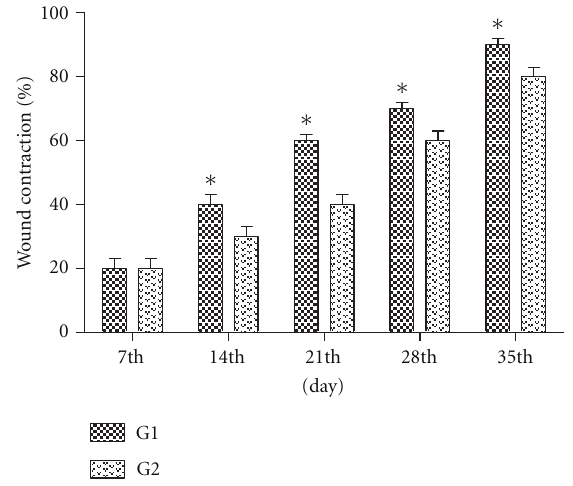
Figure 4: E ff ect of hydrogel topical application on the burn wound expressed as percentage of wound contraction. G1 = Treatment, G2 = Control. n = 2. Values are mean ± SEM. ∗ P < 0 .